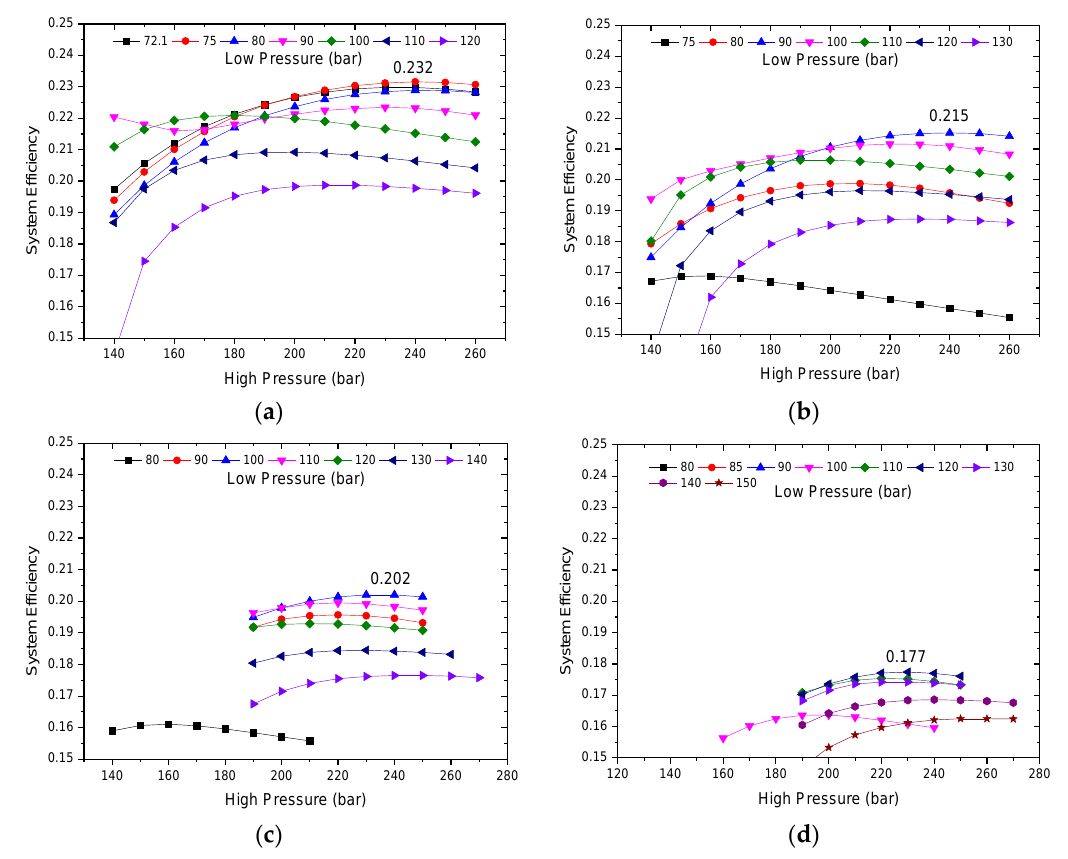
Figure 4. System efficiency of S-CO 2 power cycle for high-pressure side at given cooling temperature: ( a ) 30 °C; ( b ) 35 °C; ( c ) 40 °C; and ( d ) 50 °C.